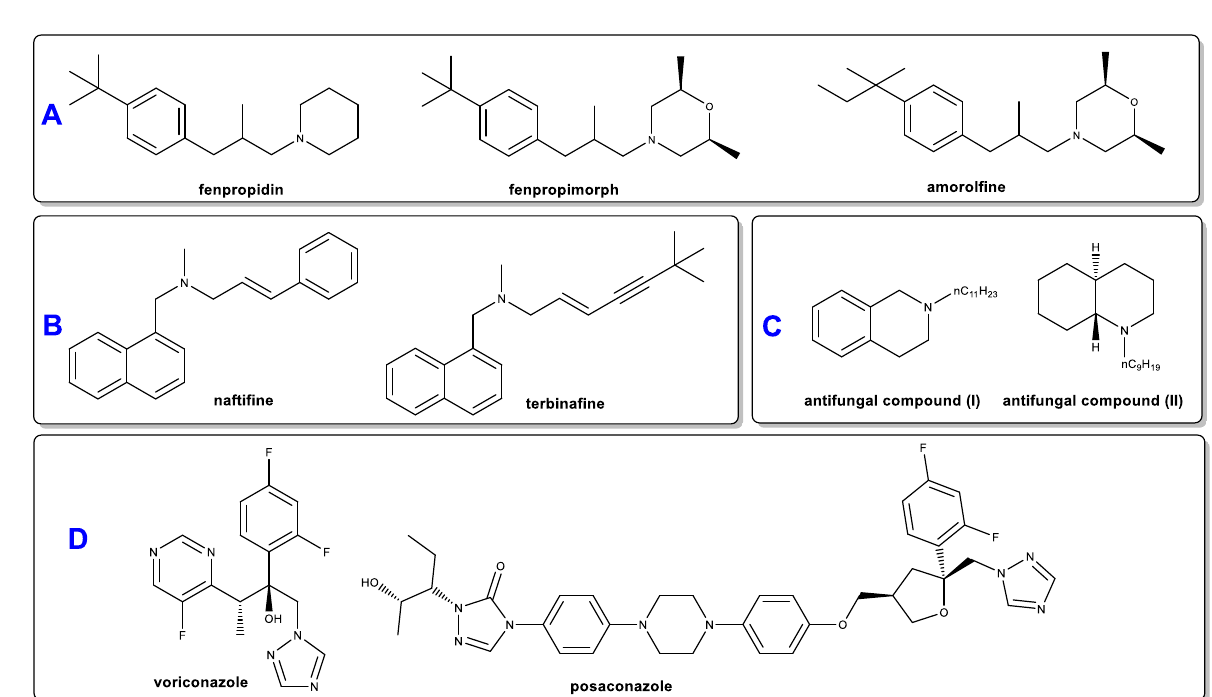
Figure 1. Structures of established antifungals. ( A ) piperidines/morpholines: fenpropidin, fenpropimorph, amorolfine; ( B ) approved allylamines: naftifine, terbinafine; ( C ) antifungal compounds (I) [9] and (II) [10] from our previous work; ( D ) approved azoles: voriconazole, posaconazole.